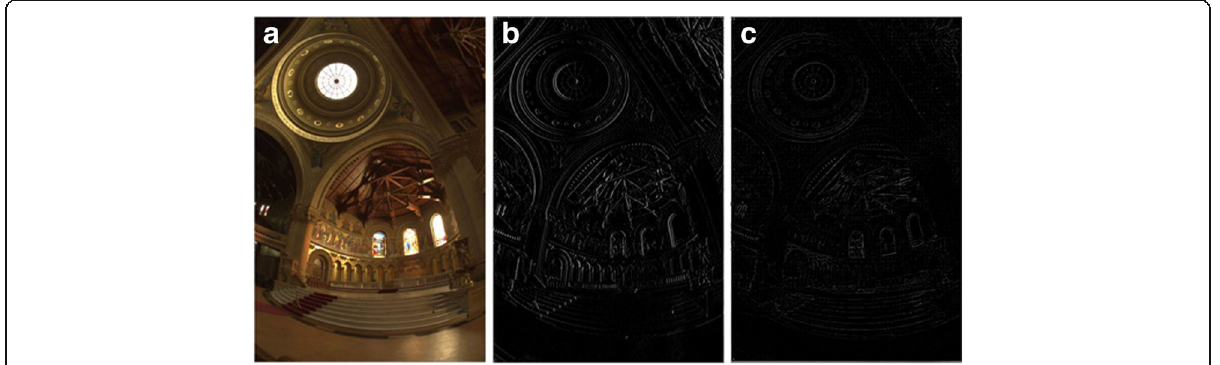
Fig. 2 Effects of Surround Suppression. a Original image. b Gradient module of a. c Boundary